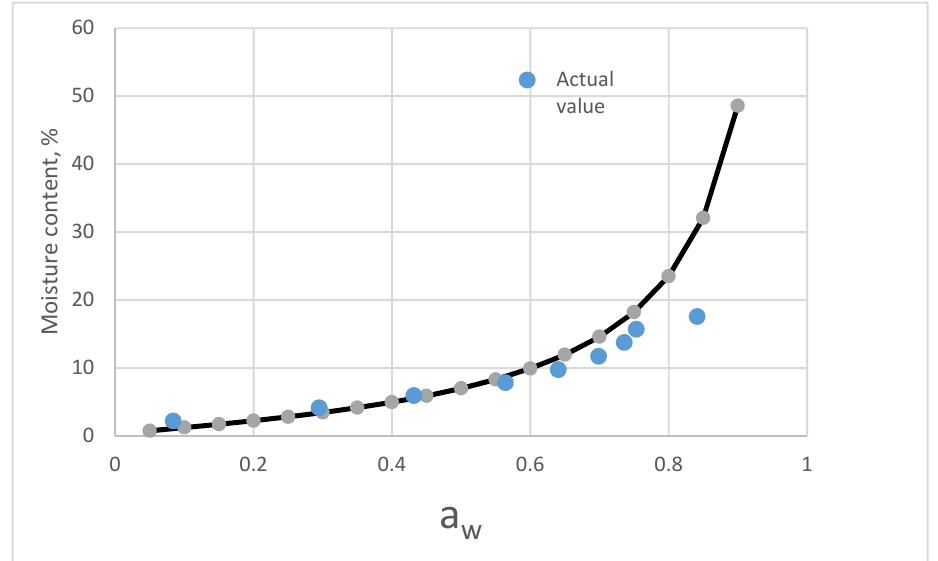
Figure 6. Comparing of the predictive values from the component model and the actual isotherm moisture of C. Morifolium flower.